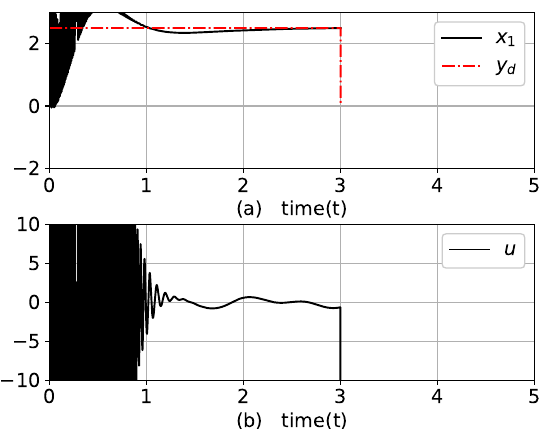
Figure 20. In the case of HGO: ( a ) y , y d , and ( b ) u